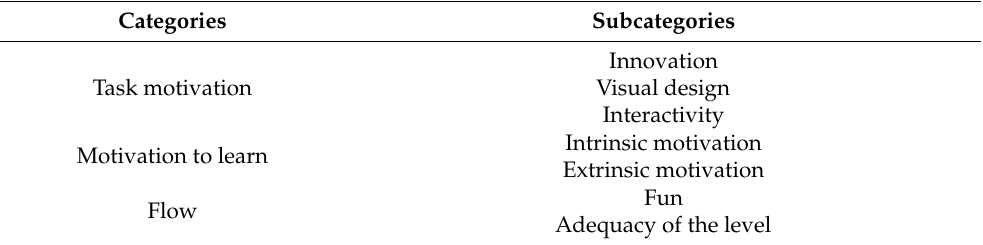
Table 1. Categories and